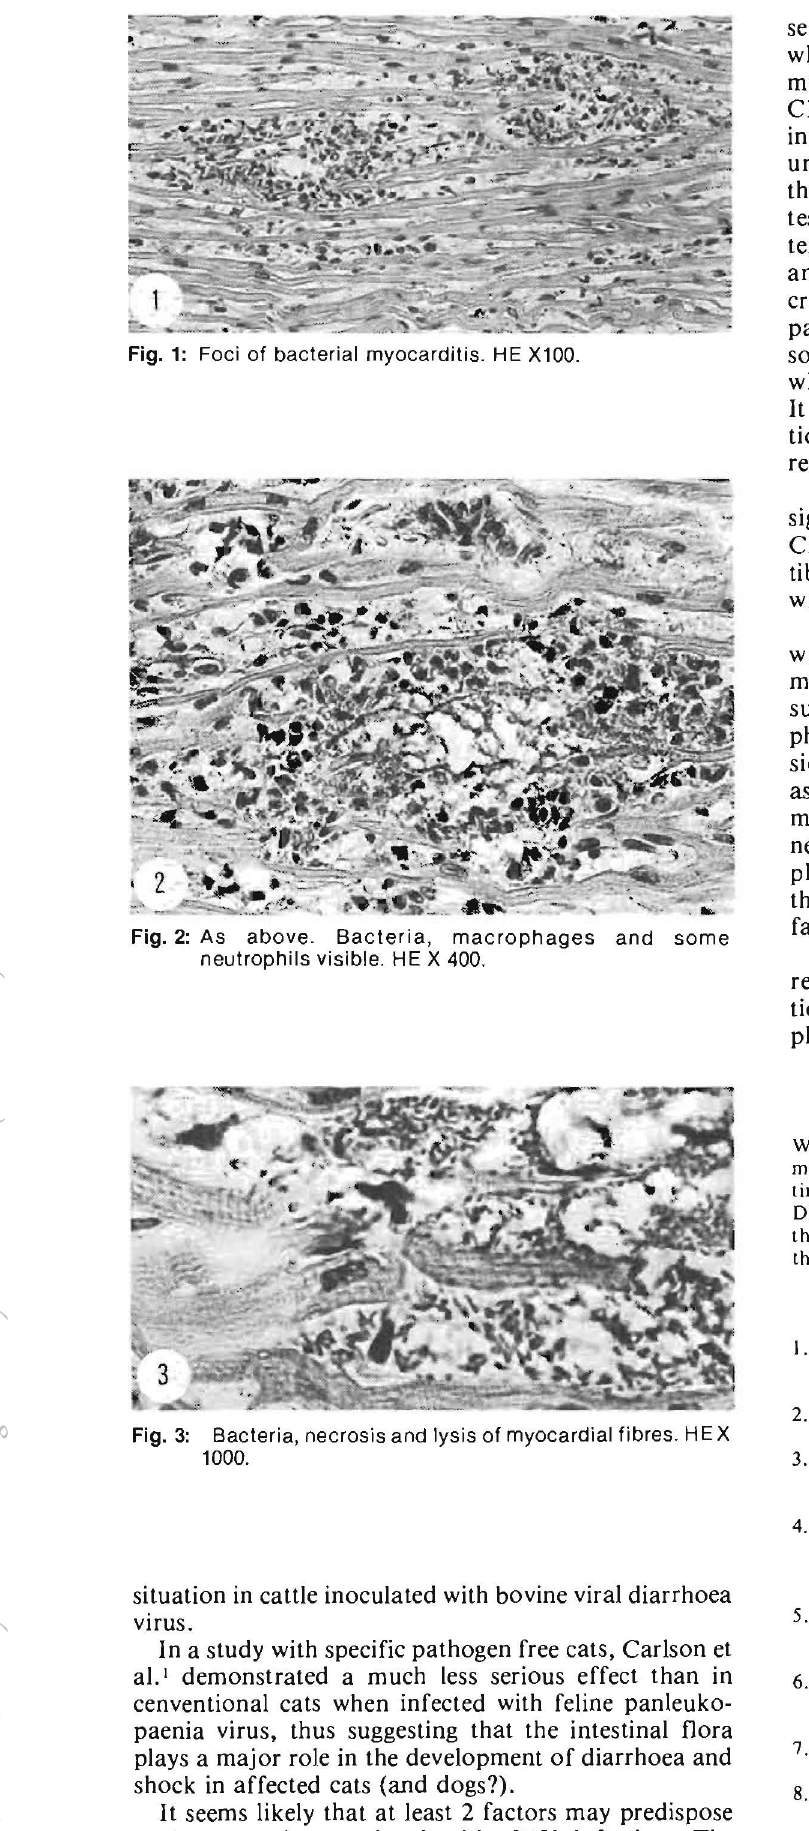
situation in cattle inoculated with bovine viral diarrhoea